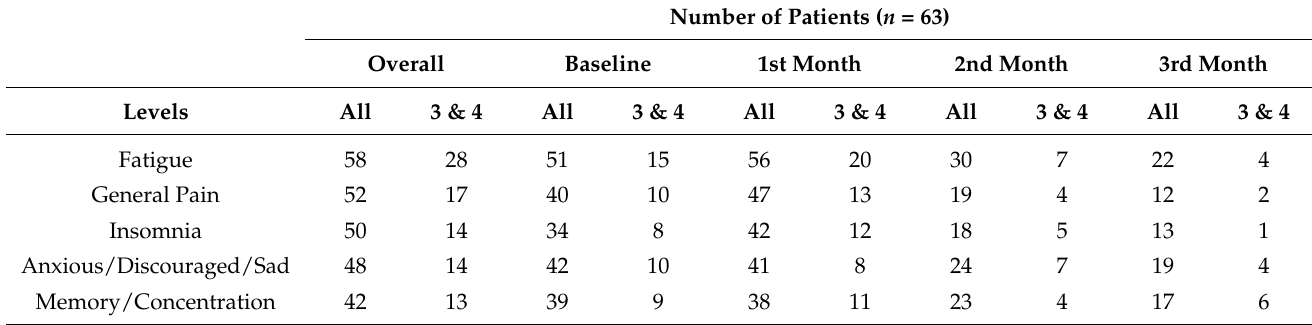
Figure 3. Number of symptoms reported by type and level. Caption: n = number of times a symptom was reported during follow-up; level 1 = mild or rarely; level 2 = moderate or occasionally; level 3 = severe or frequently; level 4 = very severe or almost constantly. Table 2. Symptoms reported by more than half of patients at baseline: number of patients reporting these symptoms overall, at baseline and during each month of follow-up.